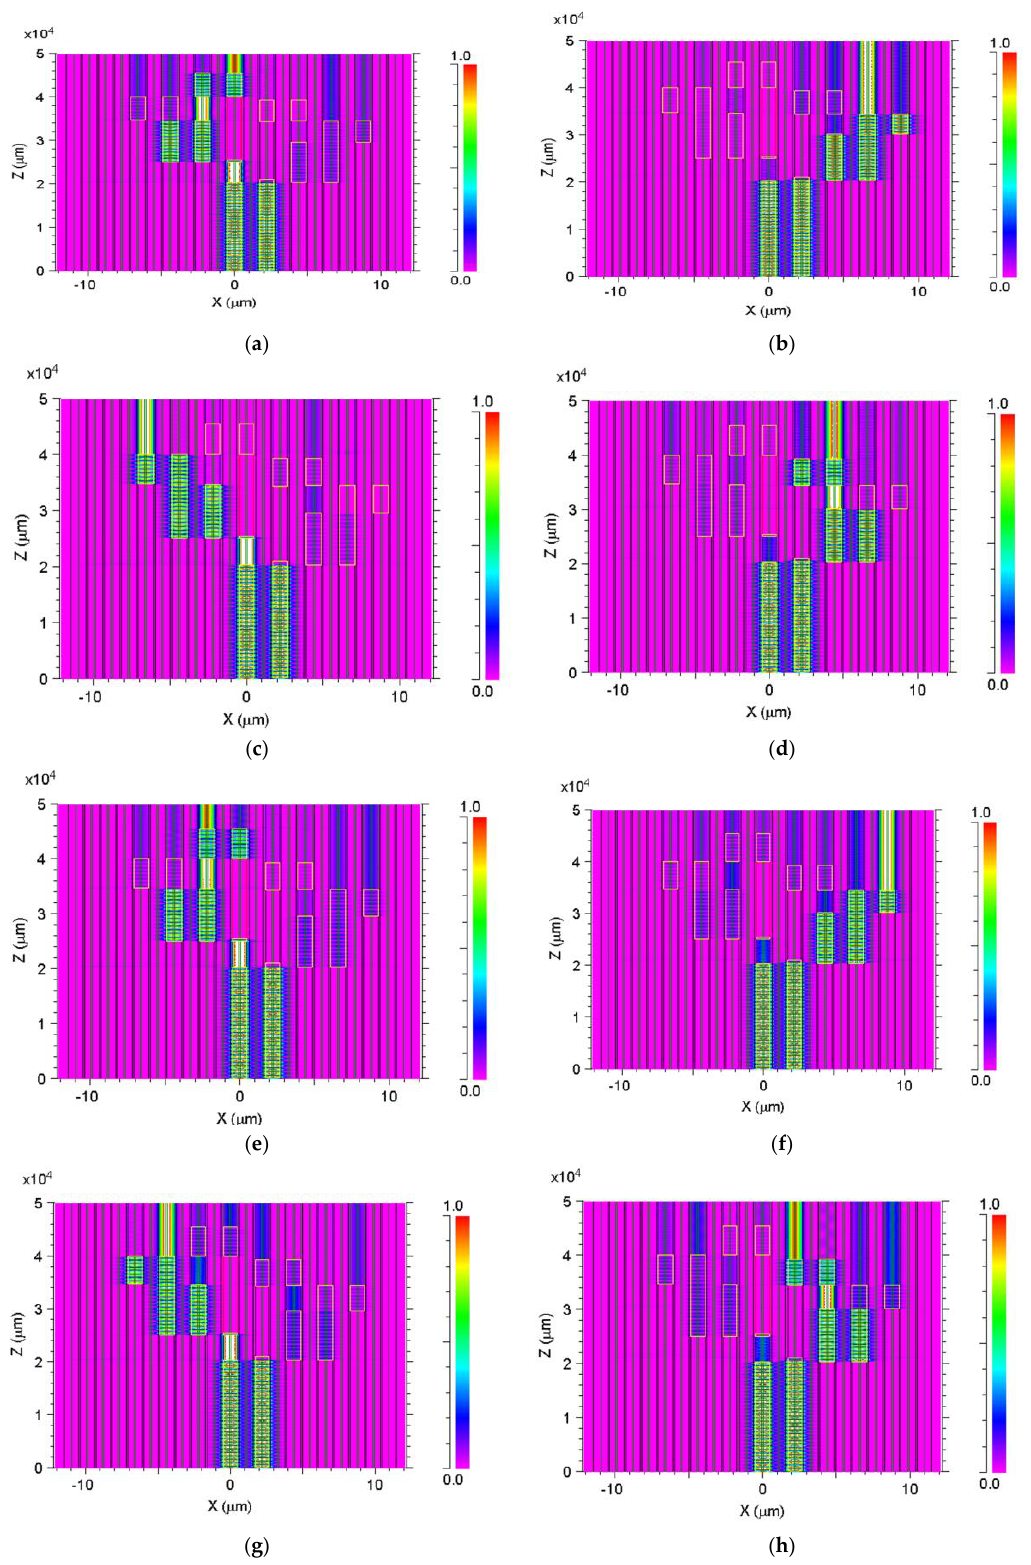
Figure 4. Intensity profile of the 1 x 8 multimode interference (MMI) wavelength demultiplexer: ( a ) λ 1 = 1530 nm (port 1). ( b ) λ 2 = 1535 nm (port 2). ( c ) λ 3 = 1540 nm (port 3). ( d ) λ 4 = 1545 nm (port 4). ( e ). λ 5 =1550 nm (port 5). ( f ) λ 6 = 1555 nm (port 6). ( g ) λ 7 = 1560 nm (port 7). and ( h ) λ 8 = 1565 nm (port 8).